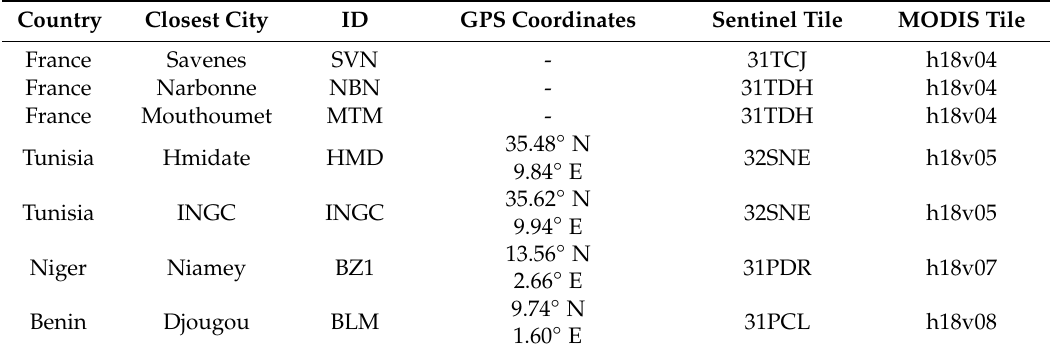
Table 2. Characteristics of the sites of